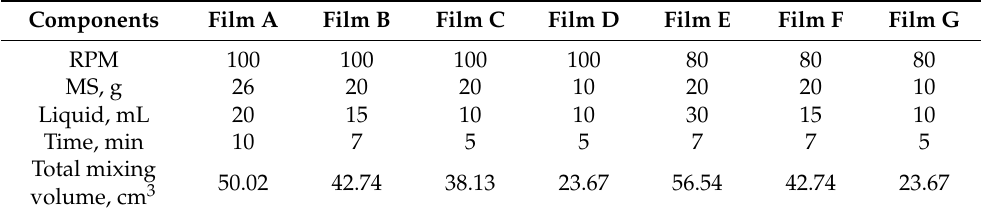
Table 1. The mixing conditions of the heat pressed films. Components